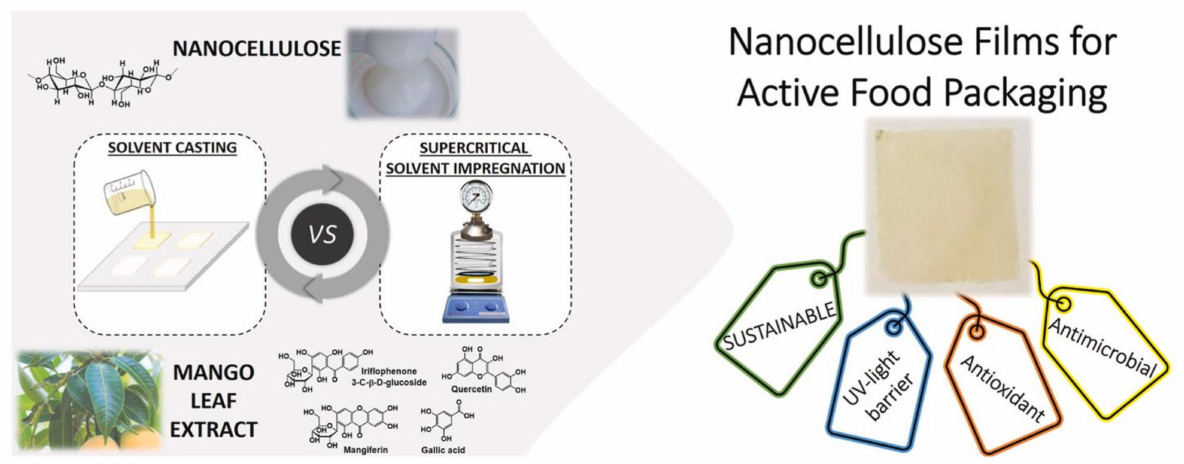
Figure 13. Schematic of the preparation of nanocellulose films via solvent casting and super-critical im- pregnation technology. Reprinted with permission from Ref. [126]. License Number: